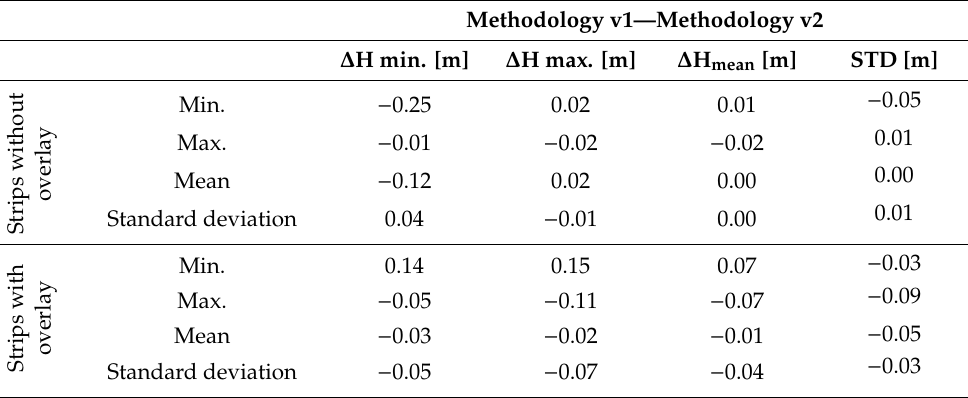
Table 10. Di ff erences between statistical characteristics for height di ff erences between methodologies. (Where: H—height, STD—standard deviation).